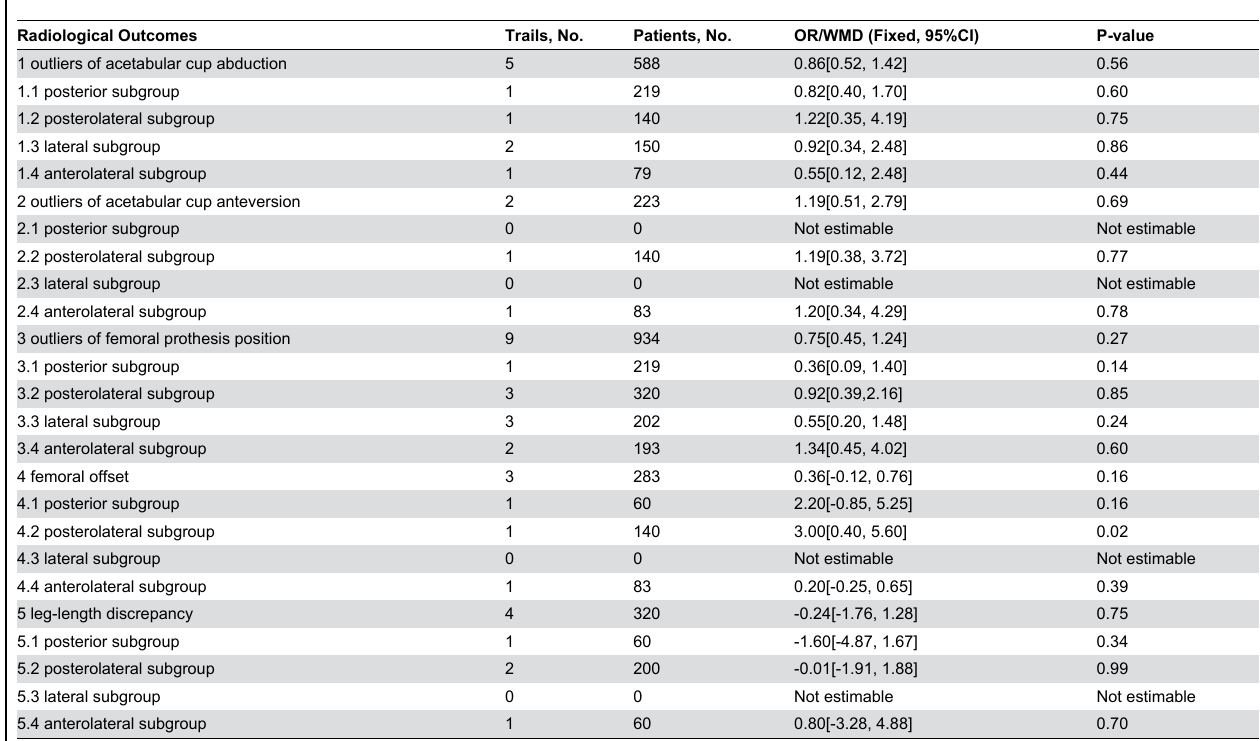
Table 2. Meta-analysis of randomized controlled trials evaluating radiological outcomes.